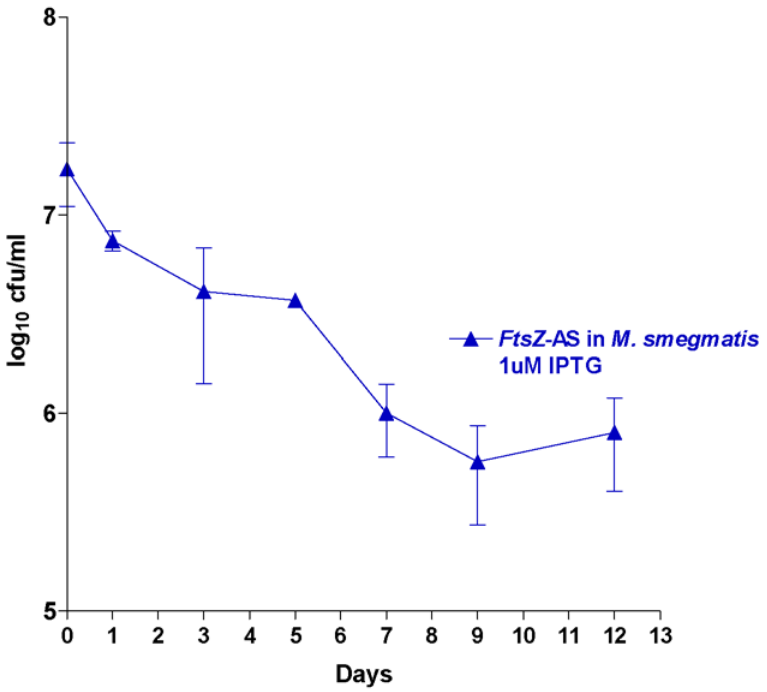
Figure 6. Survival kinetics of M.smegmatis (harbouring M.tuberculosisFts Z-AS plasmid). Induction at 1 uM IPTG of the Fts Z r-M. smegmatis shows , 1.5 log10 cfu reduction, categorizing it as a bacteriostatic target.